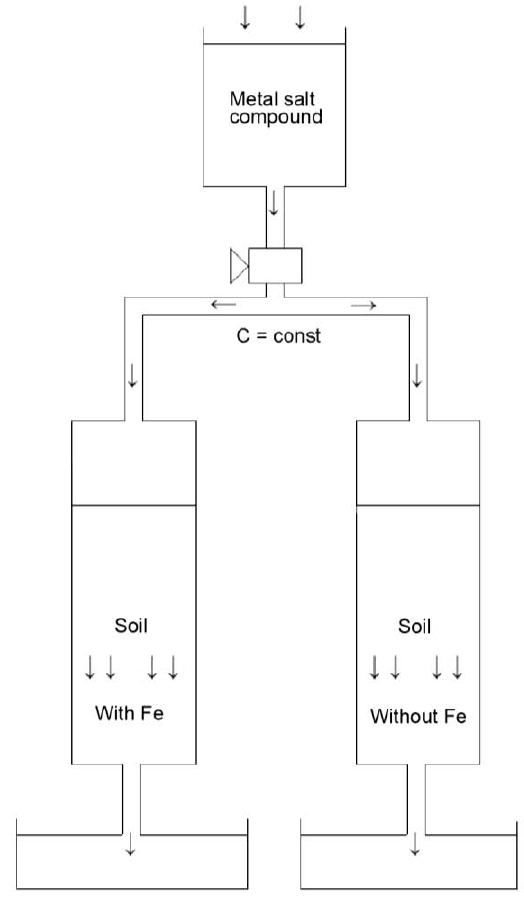
Fig. 1. Scheme of the experiment of iron impact on heavy metals migration in the soil